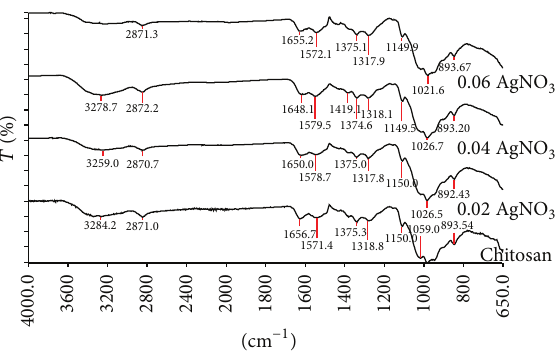
Figure 2: FTIR spectra of chitosan-Ag nanoparticle materials synthesized with 0.02 M, 0.04 M, and 0.06 M AgNO 3 and pure chitosan.